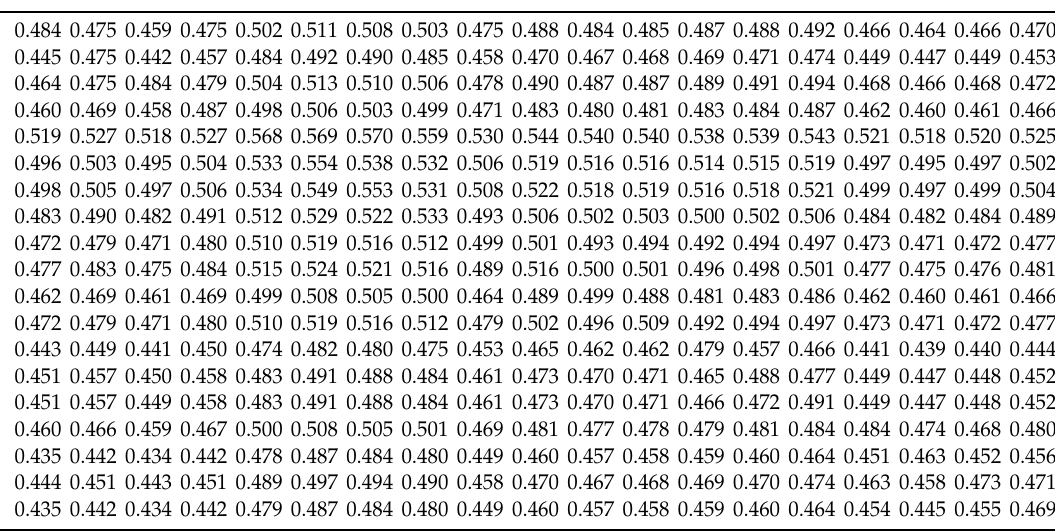
Table 4. The initial influence matrix D .